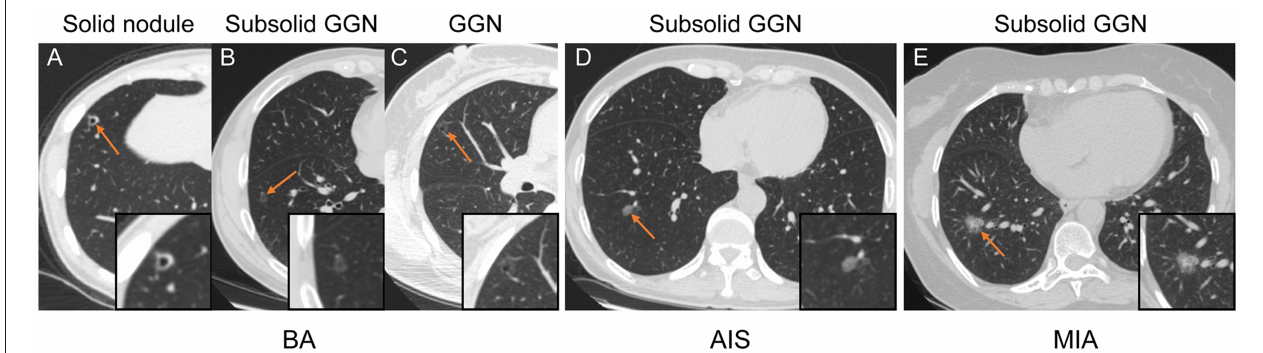
FIGURE 1 | Representative CT images of patients with BA (A–C) , AIS (D) , and MIA (E) . (A–C) Axial CT image of BA presenting as a solid nodule (A) , subsolid GGN (B) , and GGN (C) with round to oval shape, pseudo-cavitation, smooth margins, and clear tumor–lung interface. (D) Axial CT image of AIS that presents as a subsolid GGN with an oval shape, smooth margins, and clear tumor–lung interface. (E) Axial CT image of MIA appearing as a subsolid GGN with an oval shape, small spiculated margin, shallow lobulation, and clear tumor–lung interface.